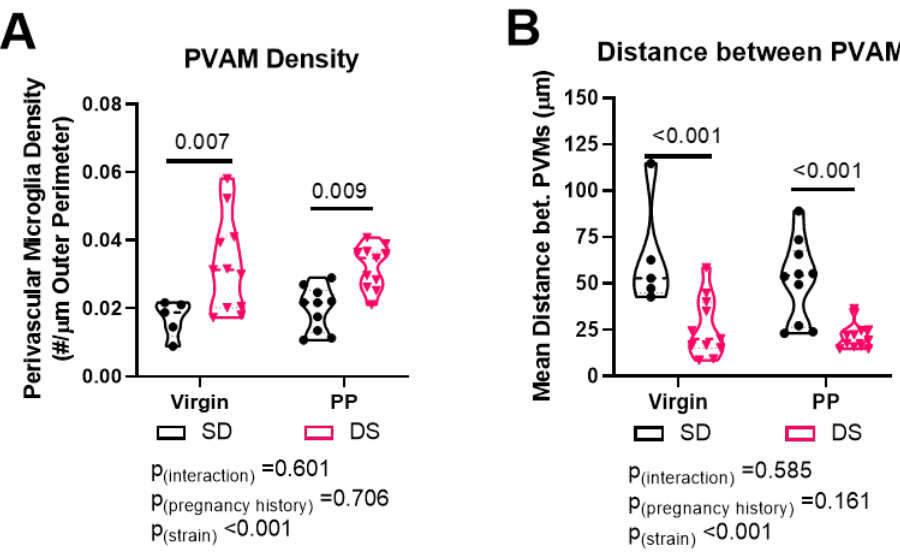
Figure 2. Pial vessel coverage by PVAMs is higher in Dahl-SS/Jr females. Violin plots showing ( A ) PVAM density and ( B ) distance between PVAM in brains from virgin and prior pregnant Dahl-SS/Jr rats compared to SD rats. Individual data points per rat are shown.